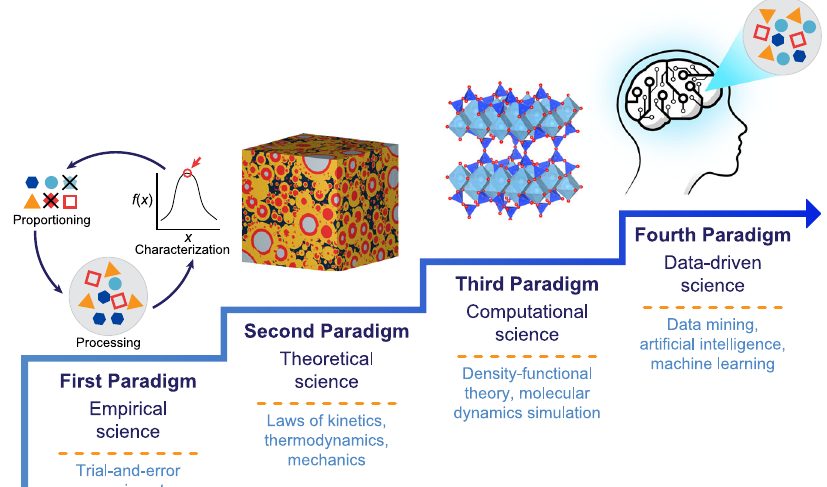
Fig. 1 Four paradigms of concrete science: empirical, theoretical, computational, and data-driven. From left to right, representative examples include: trial-and-error, iterative experiments (proportioning, processing, and characterization); numerical simulations on cement hydration (e.g., hydration, morphology, and structural development model, HYMOSTRUC 10 ); molecular dynamics simulations on cement hydrates (e.g., calcium silicate hydrate gel 224 ); and arti fi cial intelligence and machine learning predictions using experimental and computational data. Figure adapted with permission from ref. 225 , CC BY